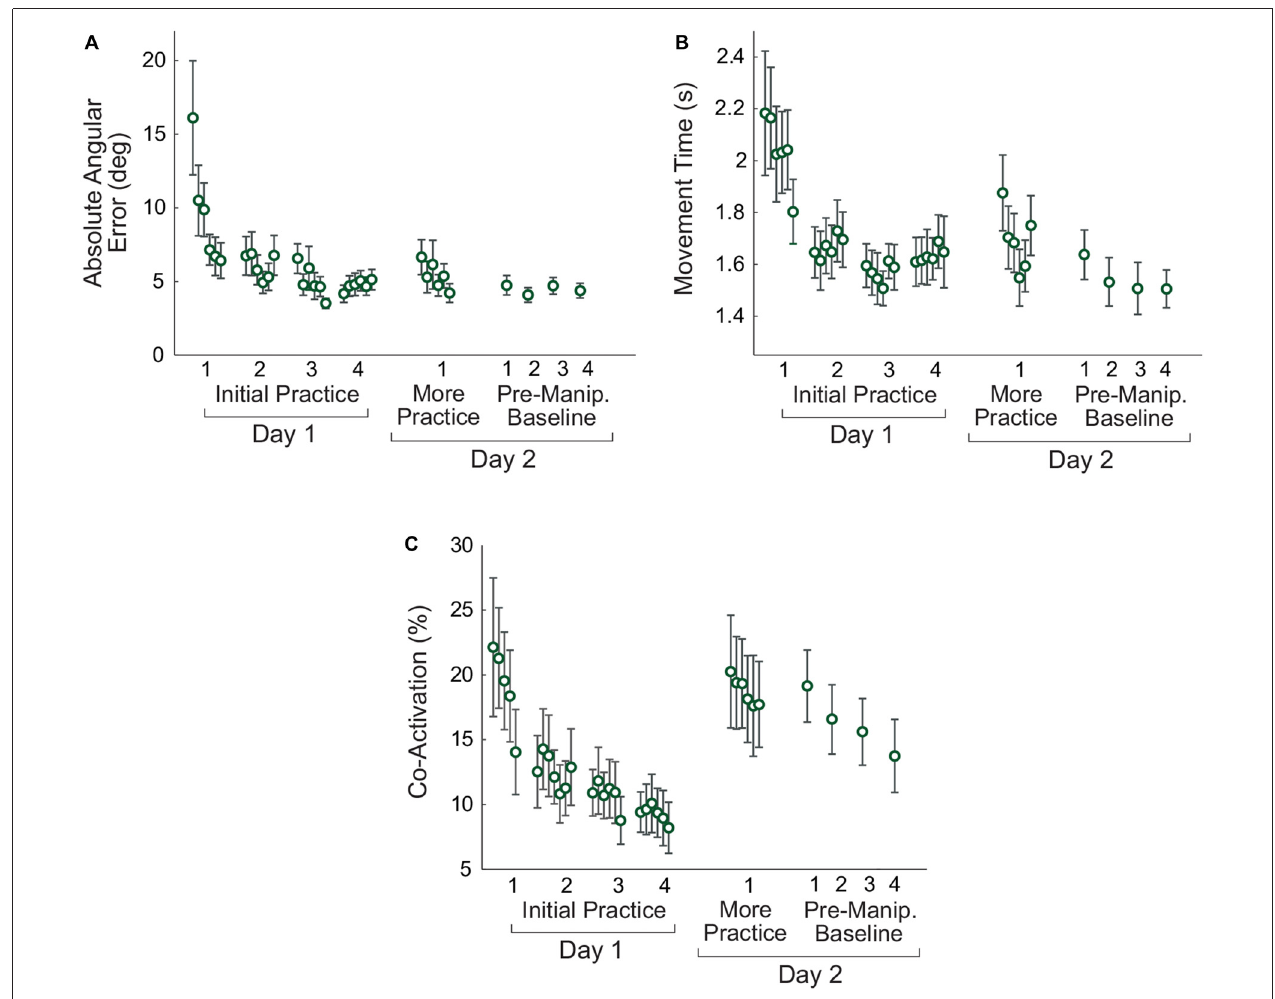
FIGURE 5 | Changes in non-manipulated virtual arm trials with practice. Measures of task performance, the absolute angular error (A) , movement time (B) , and antagonistic co-activation (C) are shown. For the initial practice on Day 1 and more practice on Day 2 the data shown are averaged in non-overlapping 10-trial bins. For the pre-manipulation baseline trials, each 15-trial block is averaged to produce one data point. Error bars represent the standard